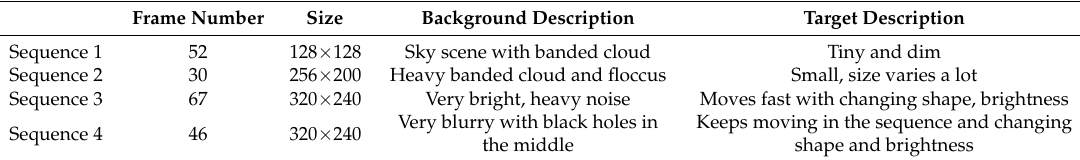
Table 4. Detailed descriptions of four real